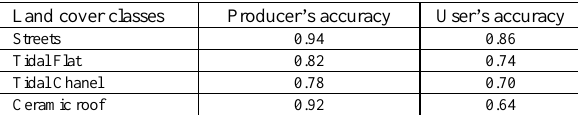
Table 01: Producer’s and User’s